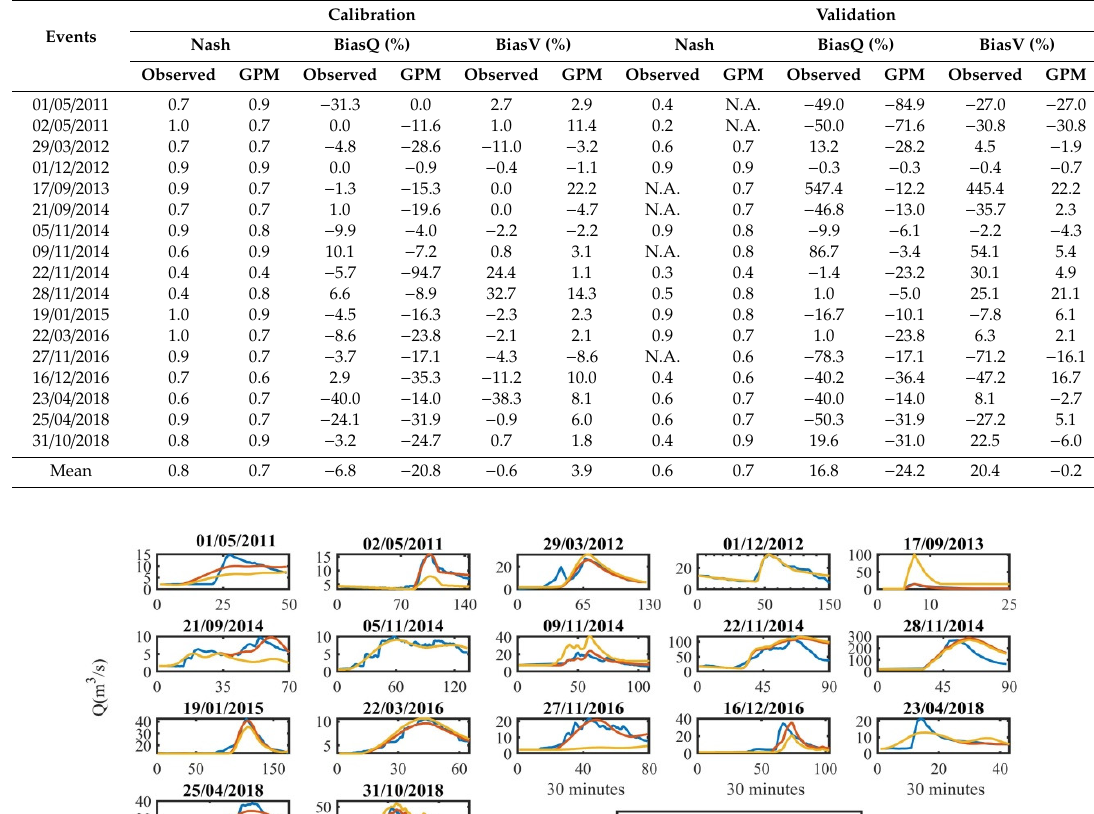
Table 6. Calibration and validation results.